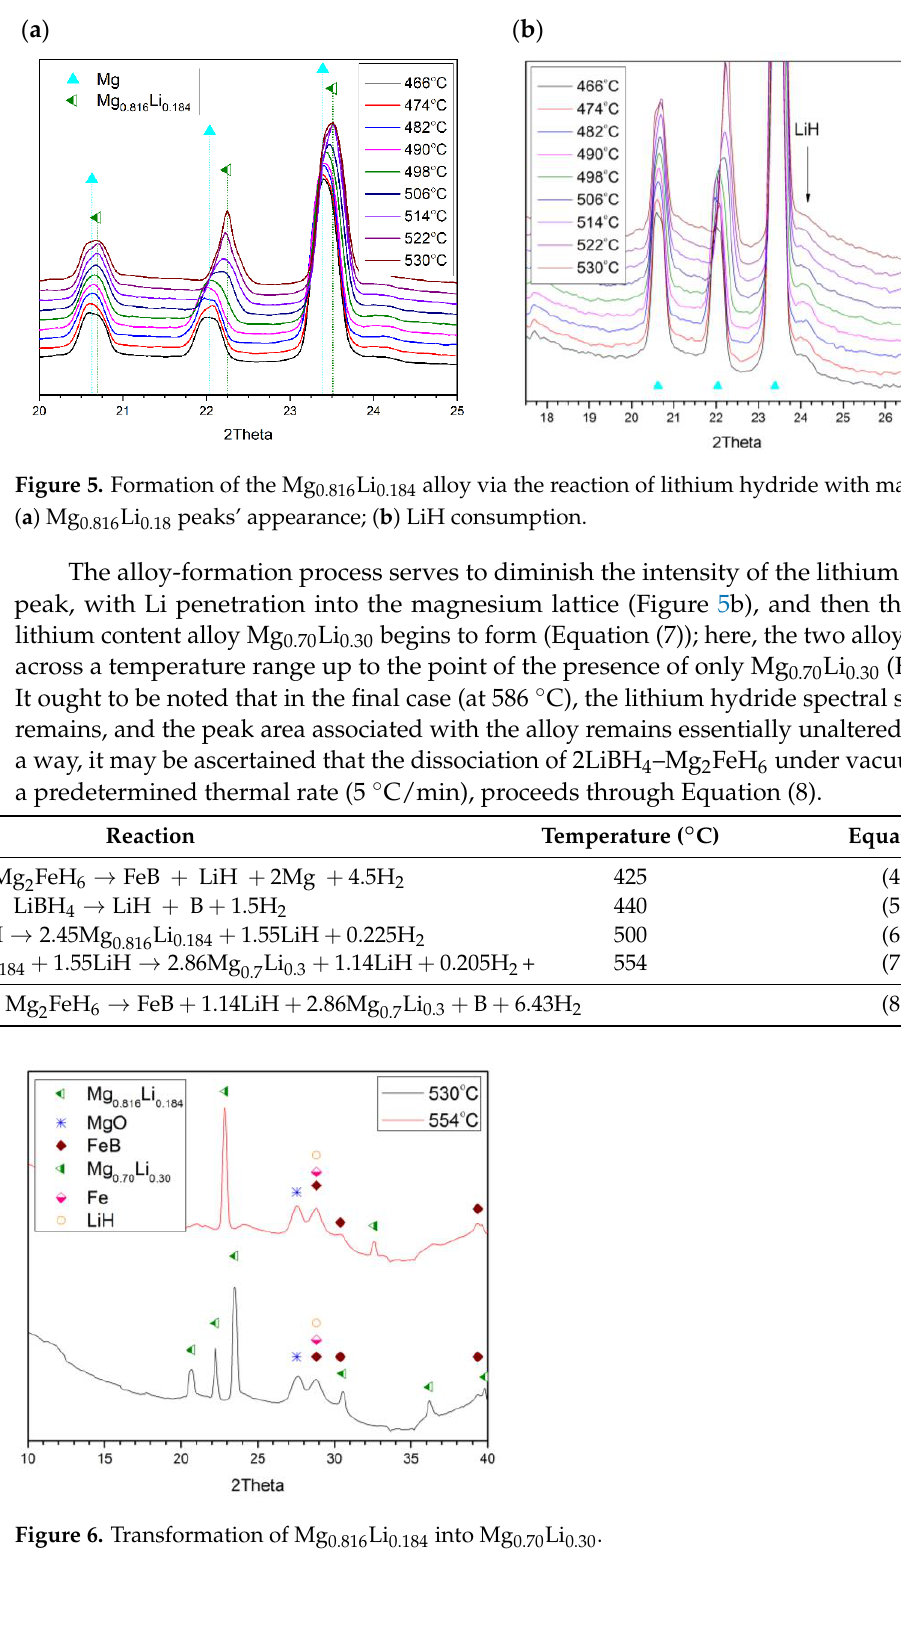
Figure 4. ( a ) Simultaneous A and B reactions ( Mg 2 FeH 6 + LiBH 4 → FeB + 2Mg + LiH + 9/2H 2 ). ( b ) LiH formation due to LiBH4 dissociation at 440 °C. Lithium hydride formed upon LiBH 4 dissociation, reacting with Mg at 500 °C, pro- ducing the Mg 0.816 Li 0.184 alloy as shown in Equation (6). From substitutional replacement